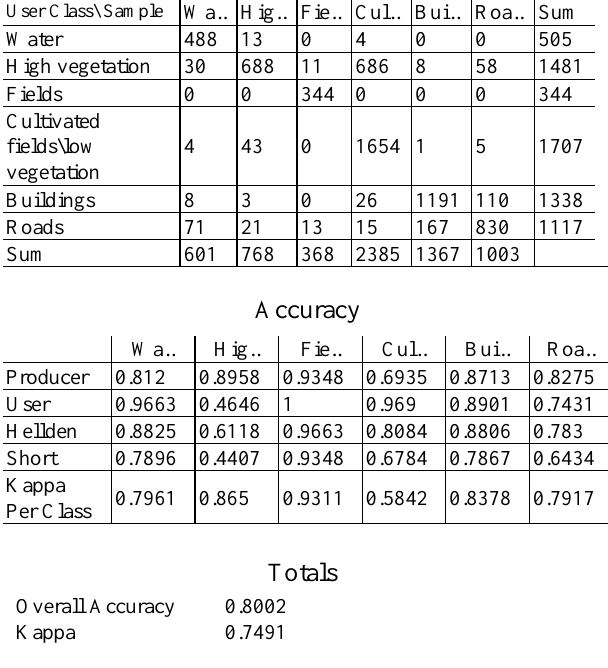
Table 4. Confusion matrix, accuracy and totals obtained by comparing the ground truth with the result of the classification.